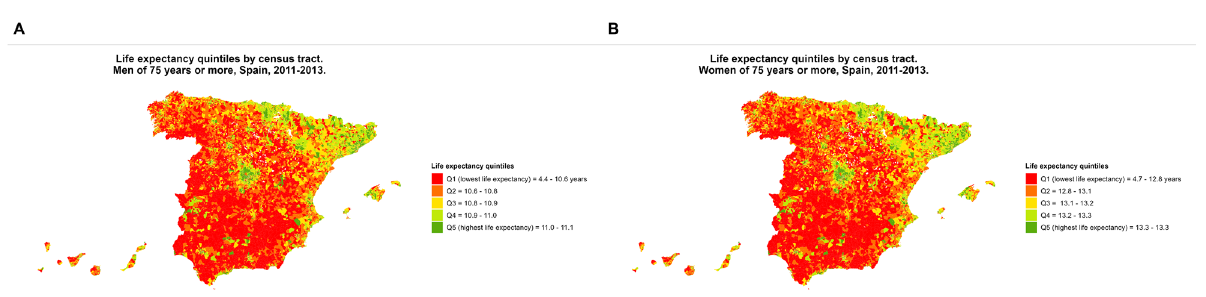
Figure 4. Life expectancy quintiles among people aged ≥ 75 years old by census tract and sex ( A : men, B : women) in Spain,